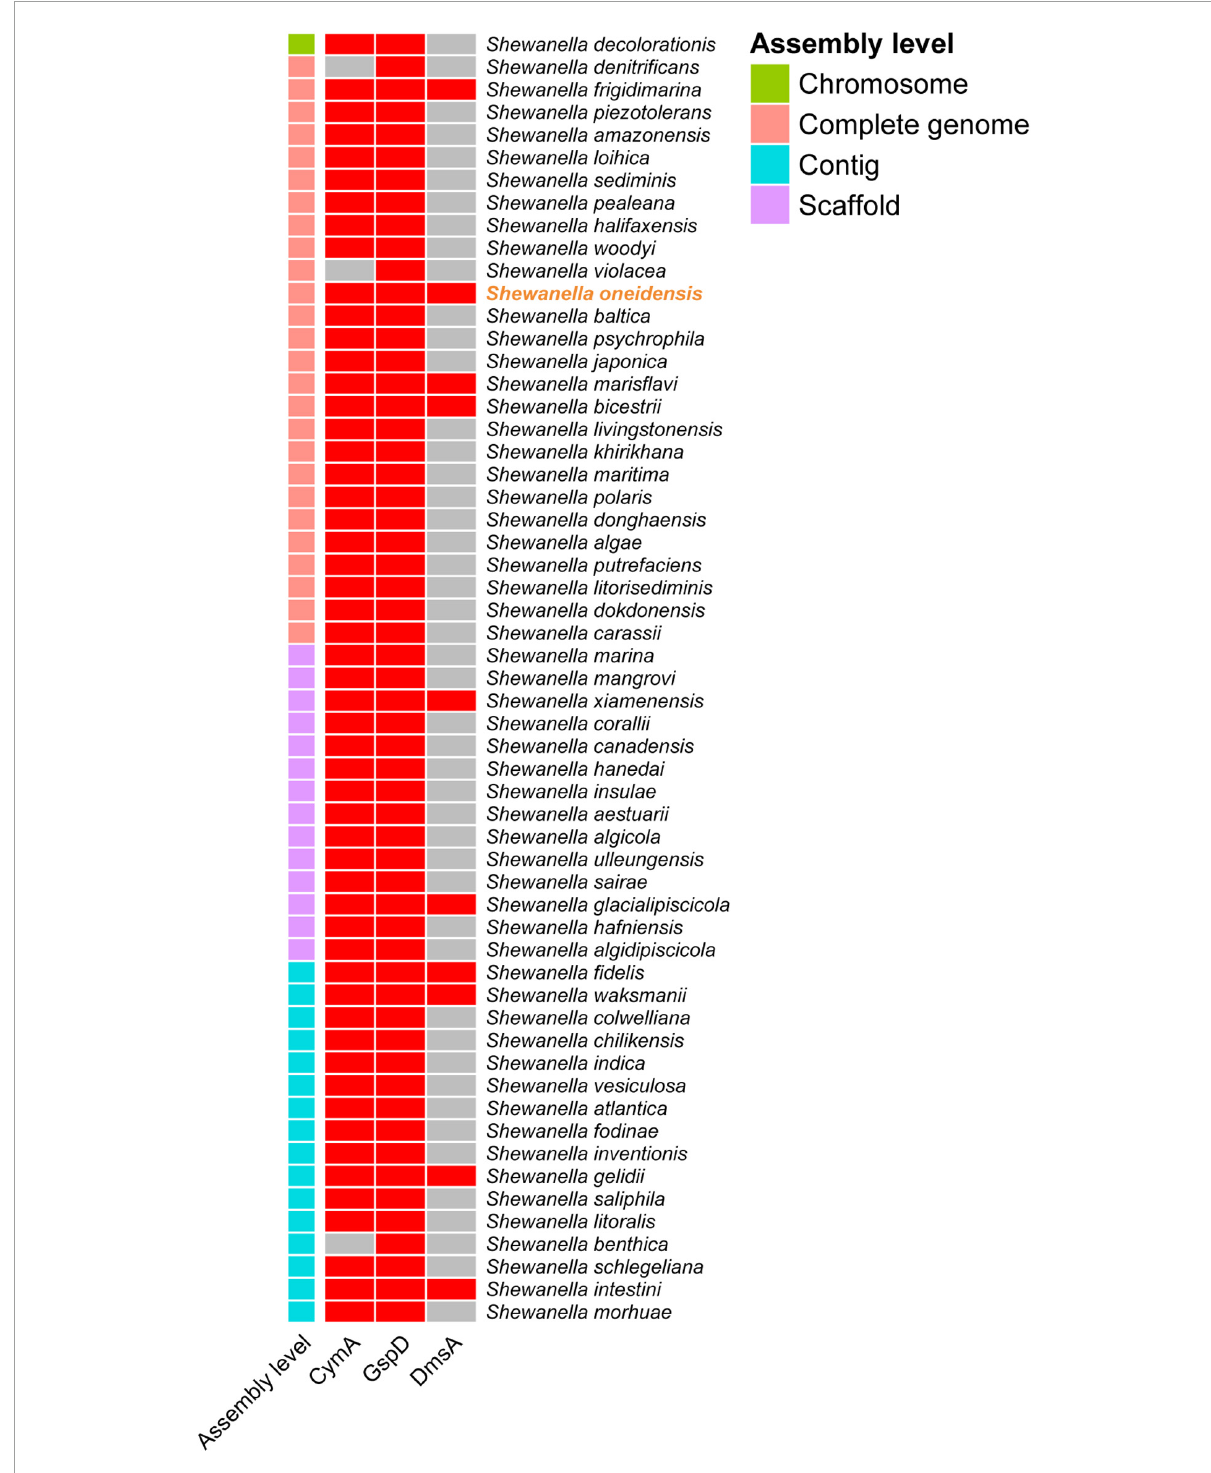
FIGURE3 Homologous protein identification of Shewanella species. Cells colored in red or gray indicate if the specific protein is identified or not,